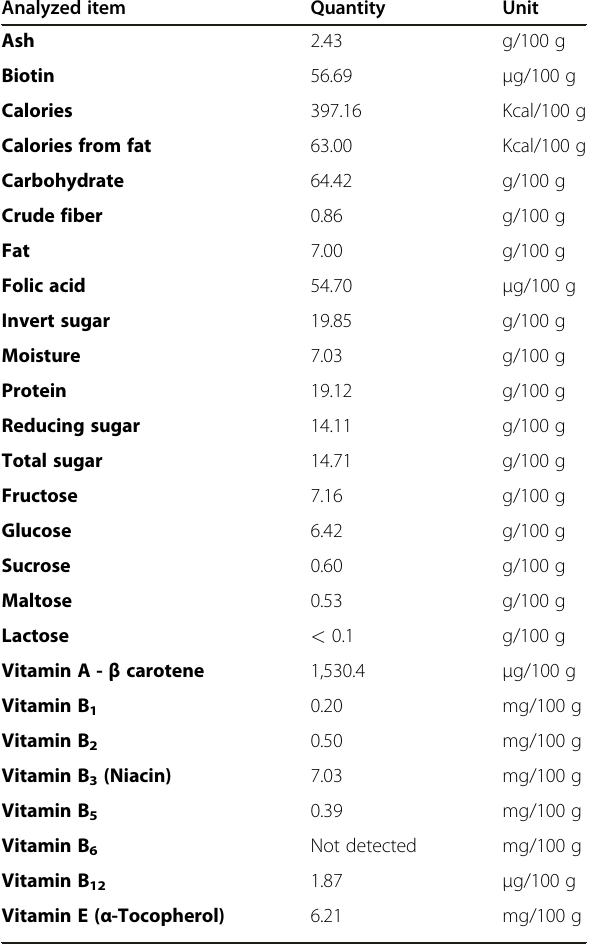
Table 6 Nutritional composition of bee corn pollen of A. mellifera from Nan province,